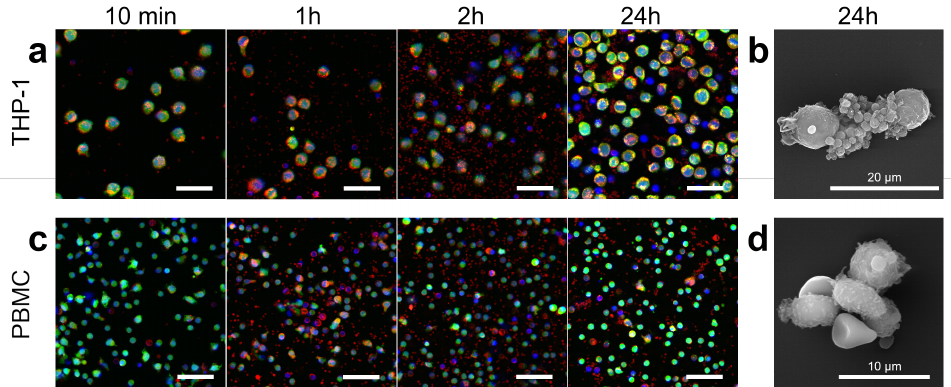
Figure 5. Microscopy of suspension cell cultures incubated with platelets for 24 h. Fluorescence microscopy of THP-1 ( a ) and PBMC ( c ), during incubation with platelets. Blue, green, and red colors correspond to Hoechst (nucleus), Calcein AM (cytoplasm), and Nile Red (preliminary staining of isolated platelet membrane) staining, respectively. All cells were stained before adding platelets and no restaining was performed 24 h later. Scale bars are 20 µ m. Scanning electron microscopy of THP-1 ( b ) and PBMC ( d ) after 24 h of incubation with platelets. Scale bars are 100 µ